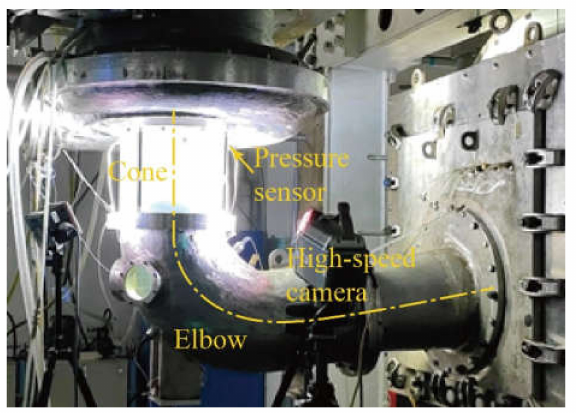
Figure 2. Draft tube section with pressure sensors on test rig in HILEM.